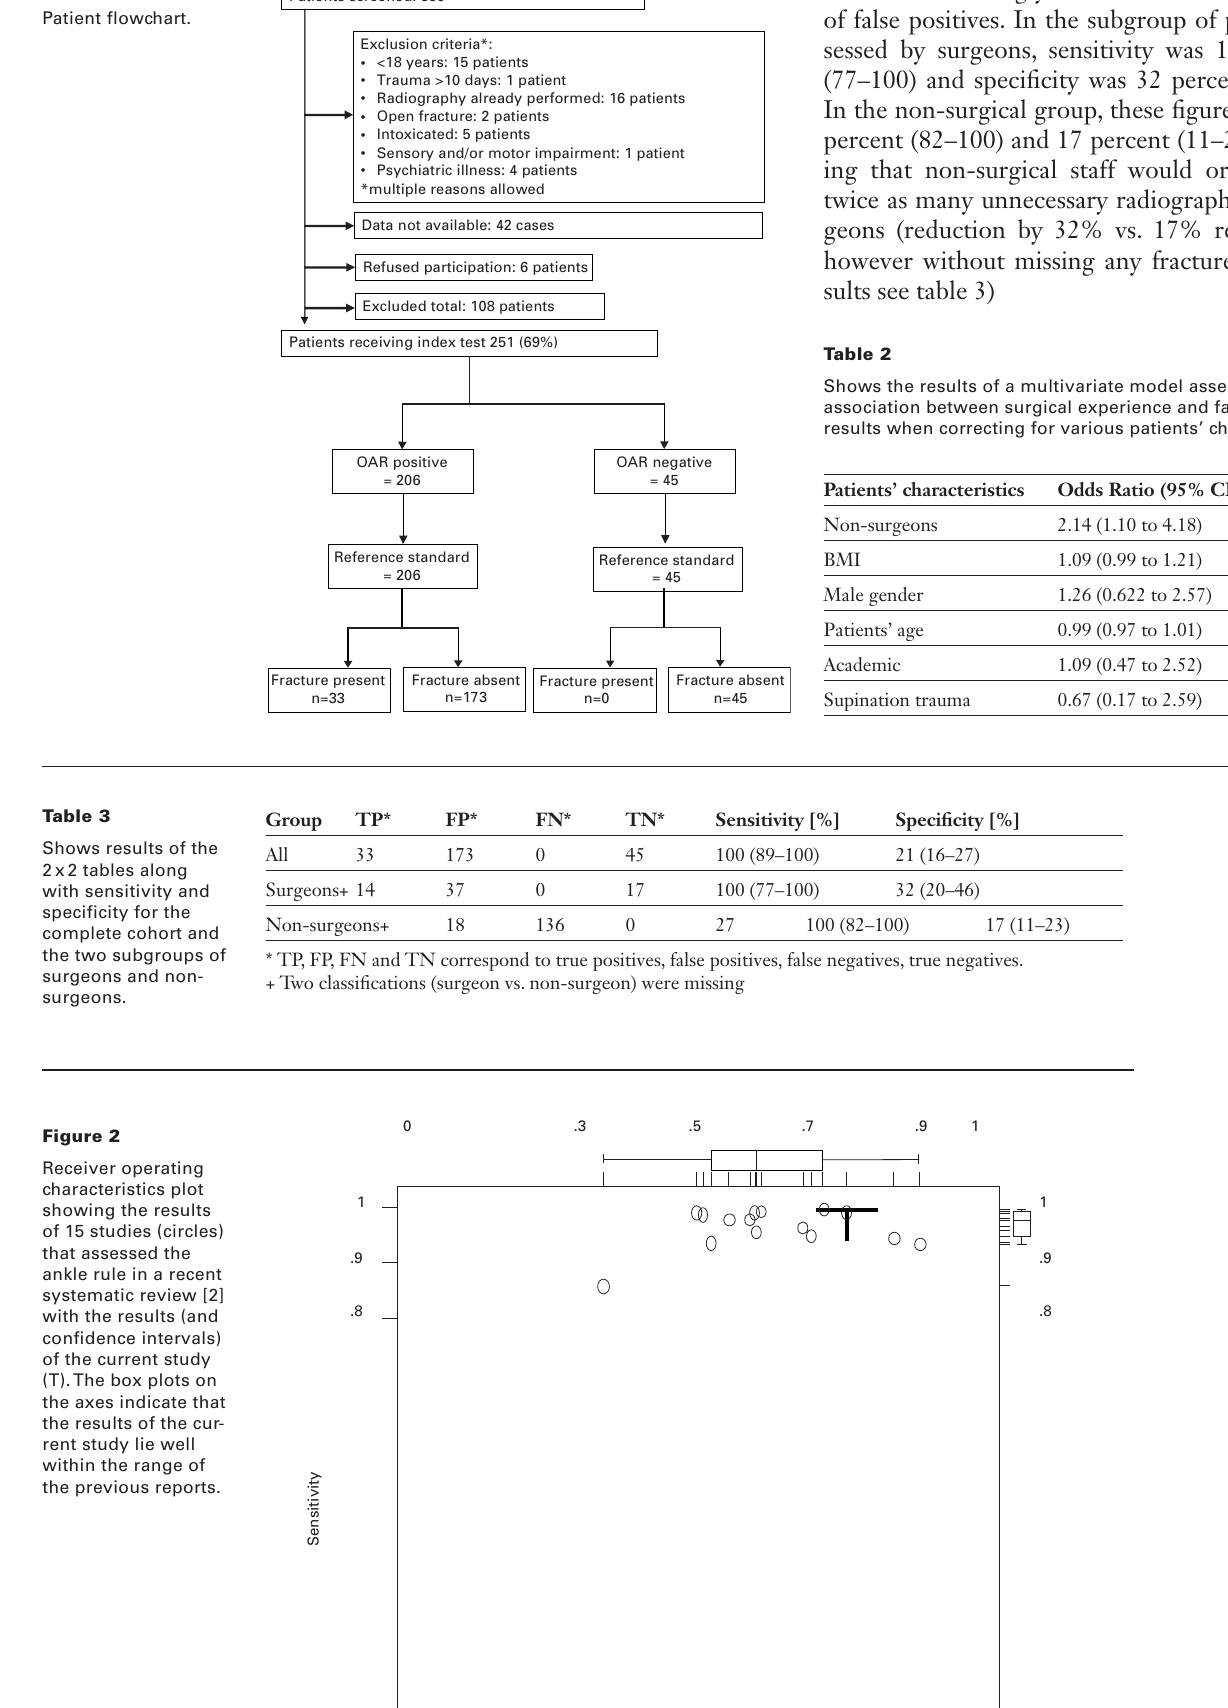
Patient flowchart.